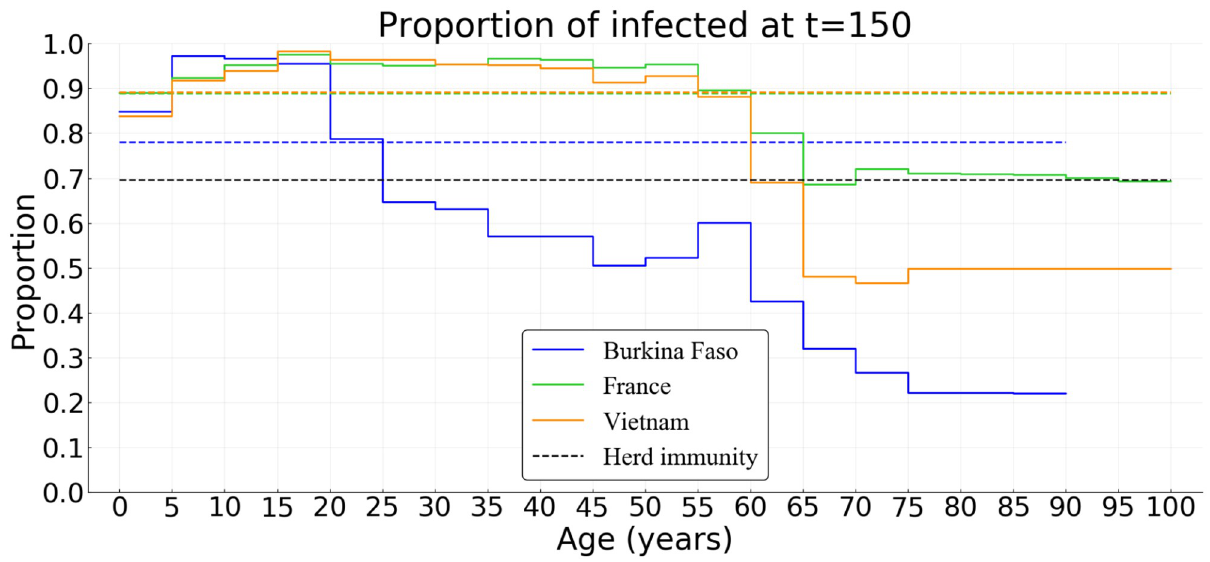
Fig 5. Simulated age distribution of the proportion of the population infected after 150 days in Burkina Faso, France, and Vietnam in absence of control measures. Parameter values are default (Table 1, R 0 = 3.3, and the proportion of paucisymptomatic infections is p = 0.5.